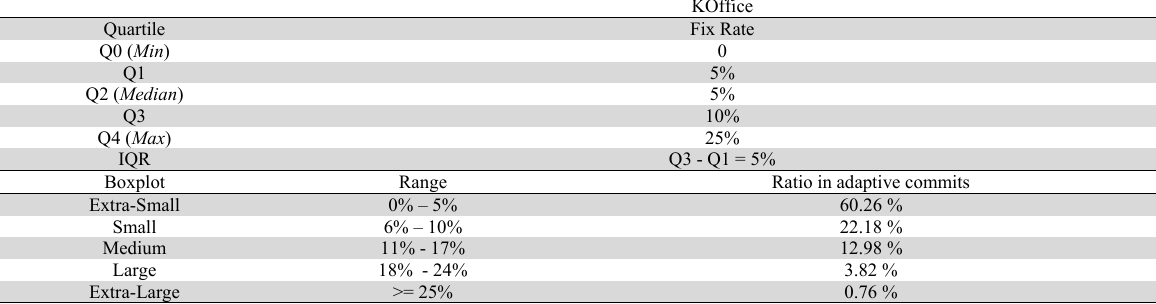
Five-Point Summary Of Adaptive Commits Categorized By Fix Rate For